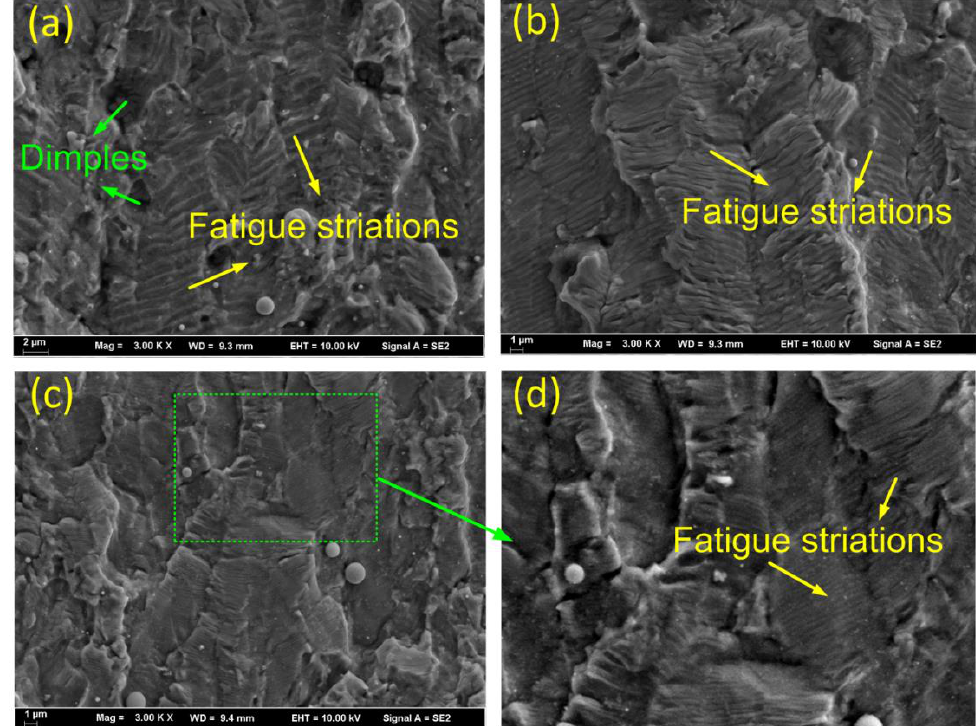
Figure 12. Fracture morphology of Ti6Al4V titanium samples: ( a ) Untreated, ( b ) RT-LSPed ( c ) and ( d ) 350 °C-WLSPed.